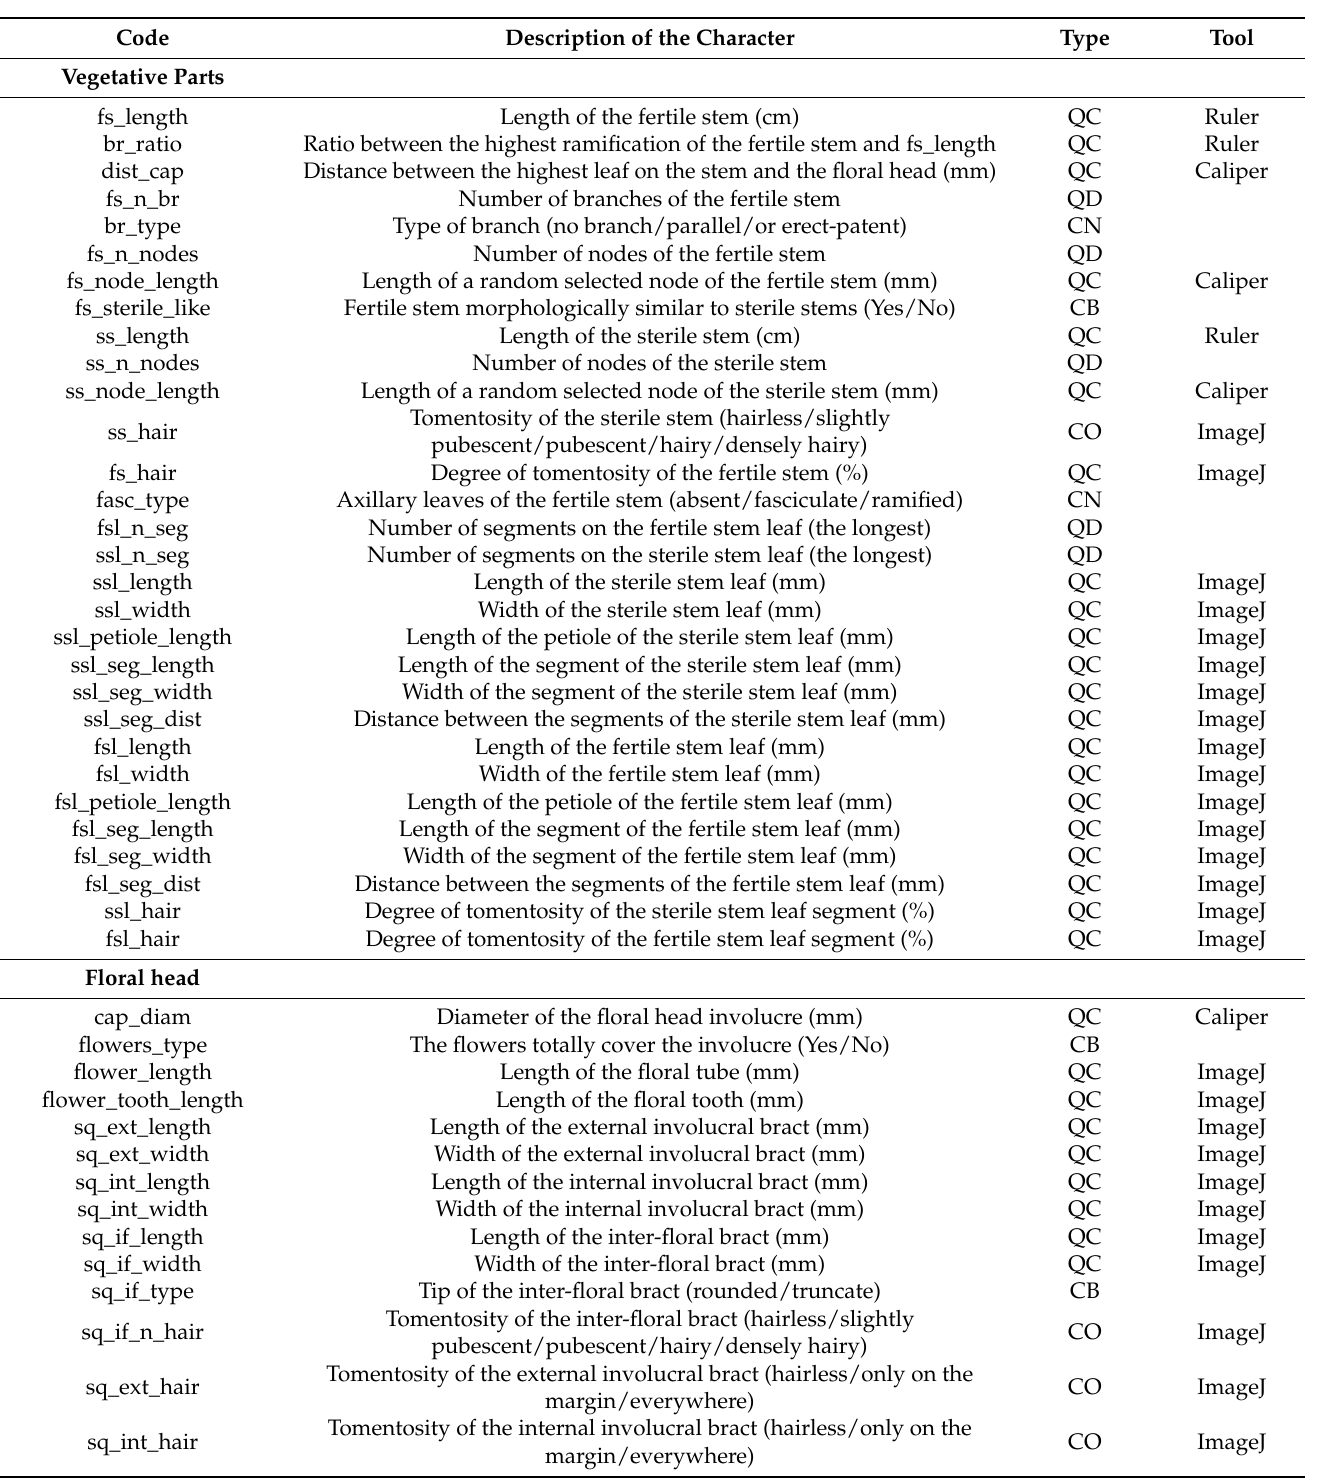
Table 4. Morphometric characters and their description. QC = quantitative continuous, QD = quanti- tative discrete, CN = nominal, CB = bimodal, and CO = ordered